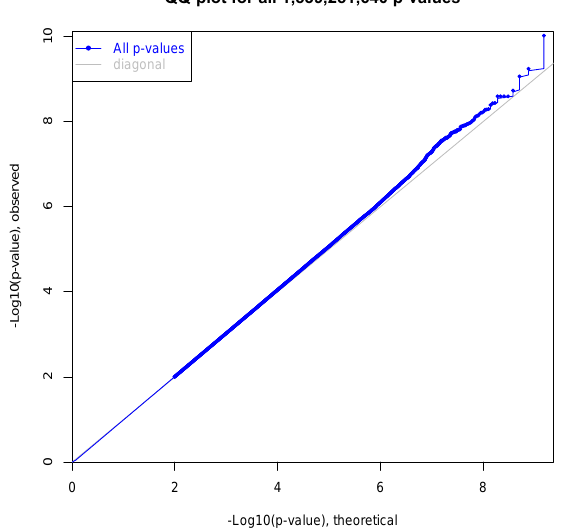
Figure 5. Quantile-Quantile plot of ~1.54 billion p -values from eQTL analysis of the MSBB inferior temporal gyrus dataset ( N = 58).